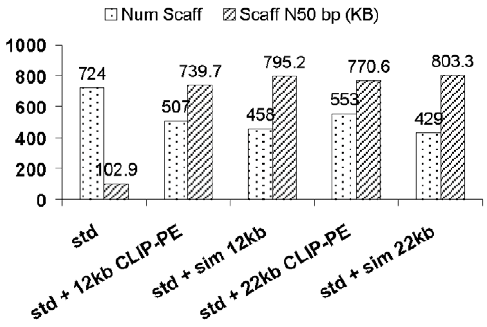
Figure 5. Assembly metrics for Saccharomycescerevisiae Illumina CLIP-PE libraries. std refers to standard Illumina 250 bp library, sim 12 kb refers to simulated 12 kb mate pair library, and sim 22 kb refers to simulated 22 kb mate pair library.